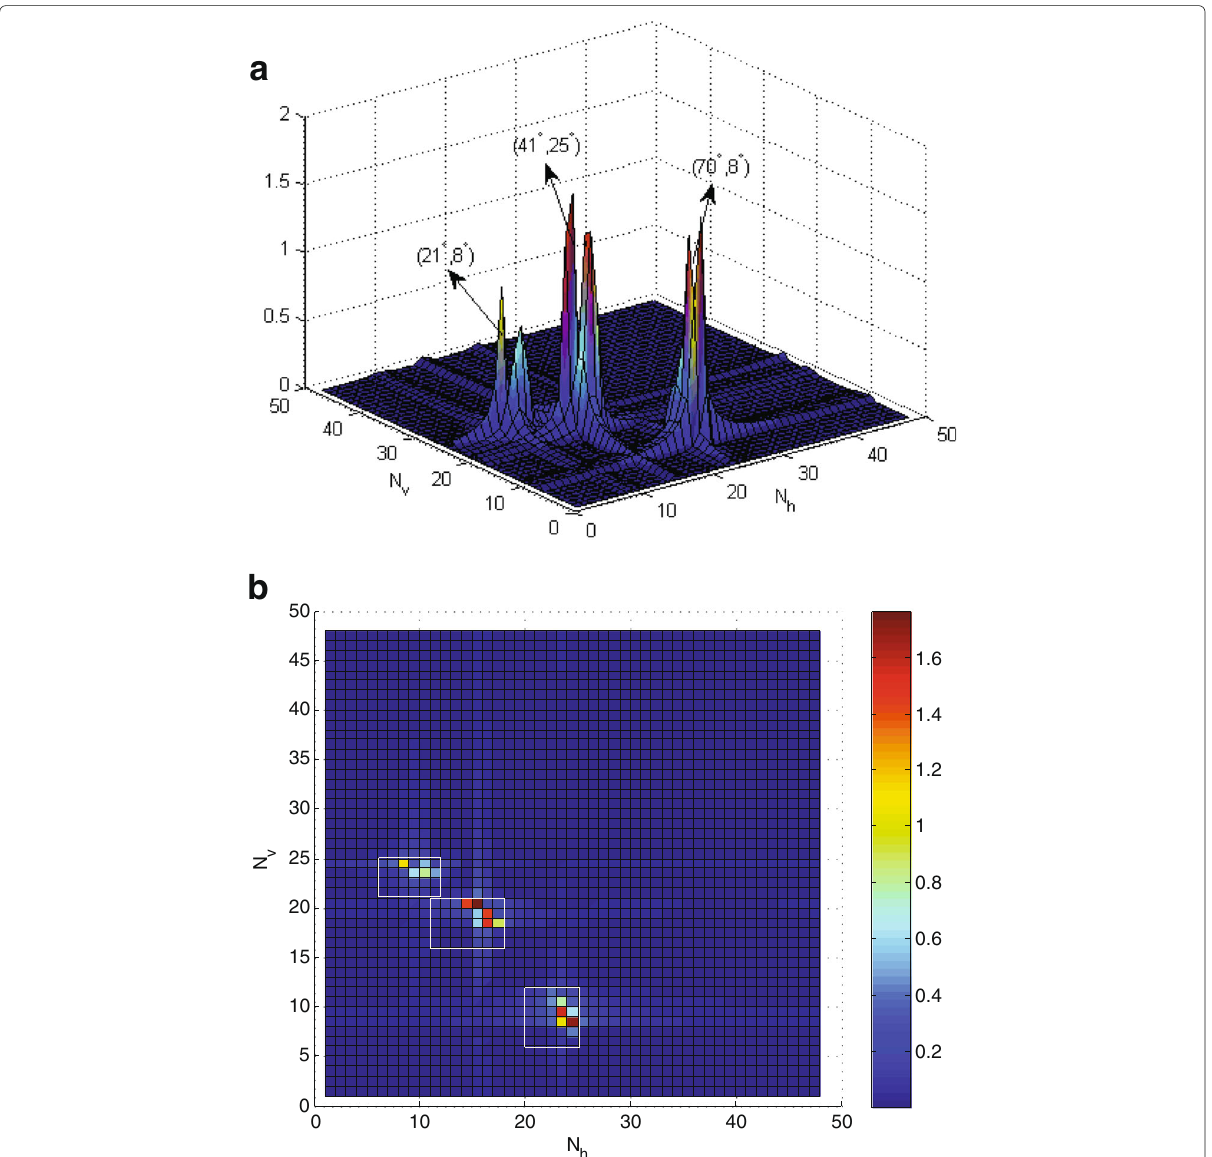
Fig. 2 Example of BD channels and their beamspaces with N v = N h = 48, the AS in the horizontal directions δ h is 10 ◦ and in the vertical directions ◦ . a The BD channels ˜ G δ ( 21 ◦ ,8 ◦ ) , ( 41 ◦ ,25 ◦ ) , and ( 70 ◦ ,8 ◦ ) . b The top view of a and the beamspace of each channel which is v is 5 k d whose DoDs are generated by (14) and is marked with rectangular